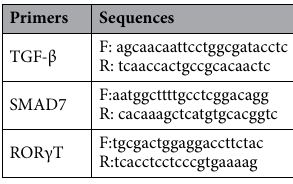
table pneumothorax or pneumatocele. COPD diagnoses were made according to GOLD2017 2 . Patients who had other chronic pulmonary diseases, such as bronchiectasia, asthma, tuberculosis, interstitial lung disease, or pneumosilicosis, were excluded. All collected lung tissues were stored at − 80 ℃ until further analysis. The present study was approved by the Institutional Human and Animal Care Ethics Committee at the Third Xiangya Hospital of Central South University and Xiangtan Central Hospital, in accordance with the principles of the Helsinki Declaration II. Written informed consent was obtained from all patients prior to their enrollment into the study. All methods were carried out in accordance with relevant guidelines and regulations and the study was carried out in compliance with the ARRIVE guidelines.